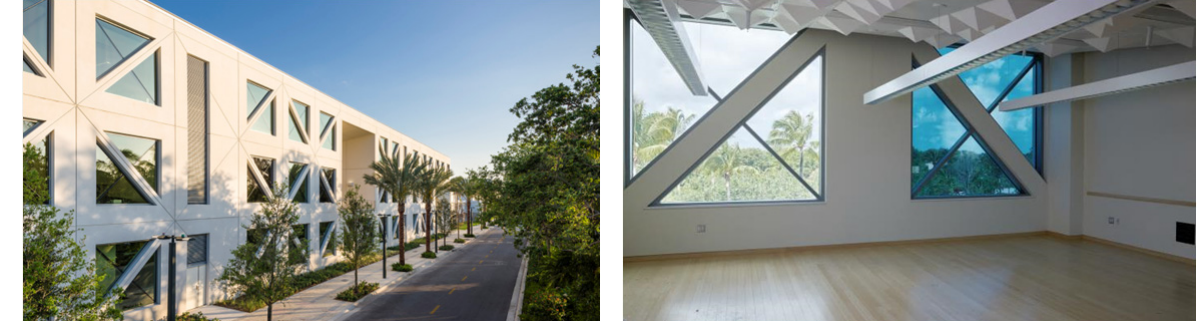
Fig. 10 Exterior and interior of the LEED Platinum-Frost School of Music at the University of Miami. EC glass enhances the indoor environment by providing natural light and outdoor views to the beautiful lakefront campus throughout the day. Photographer: Moris